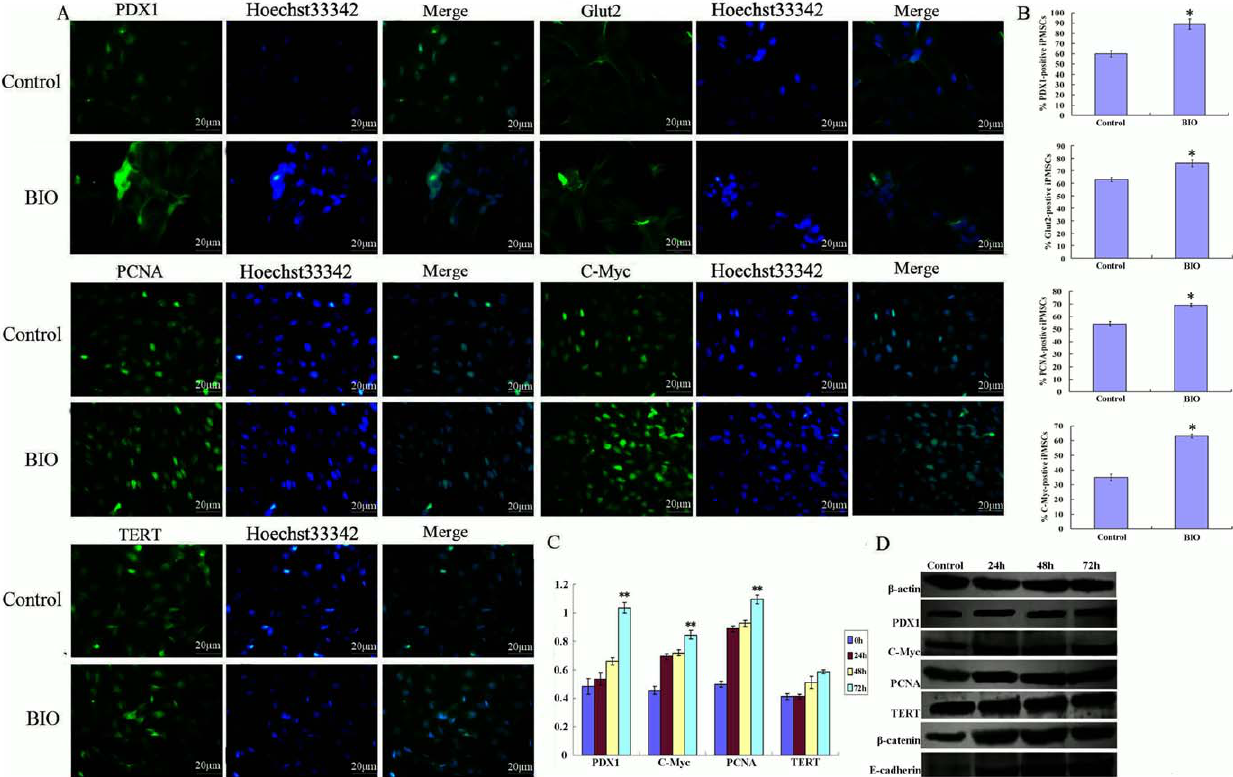
Figure 2. The GSK-3 inhibitor BIO promotes self-renewal of iPMSCs. A, Immunofluorescene staining analysis showed iPMSCs were positive for PDX1, Glut2, PCNA, C-Myc and TERT in the absence or presence of BIO, Bar=20 m m; B, The percentage of positive cells treated with BIO or not from A; C, QRT-PCR analysis showed that the expression of pancreatic islets-specific marker PDX1 and pluripotent markers C-Myc, PCNA and TERT had an up-regulated trend in BIO cultured cells (24, 48, 72 h); D, Treated with BIO (24, 48, 72 h), western blotting analysis showed the expression of PDX1, PCNA, C-Myc, TERT and E-cadherin proteins had an upward trend compared with untreated cells. Bar=20 m m, * P , 0.05, **P , 0.01.